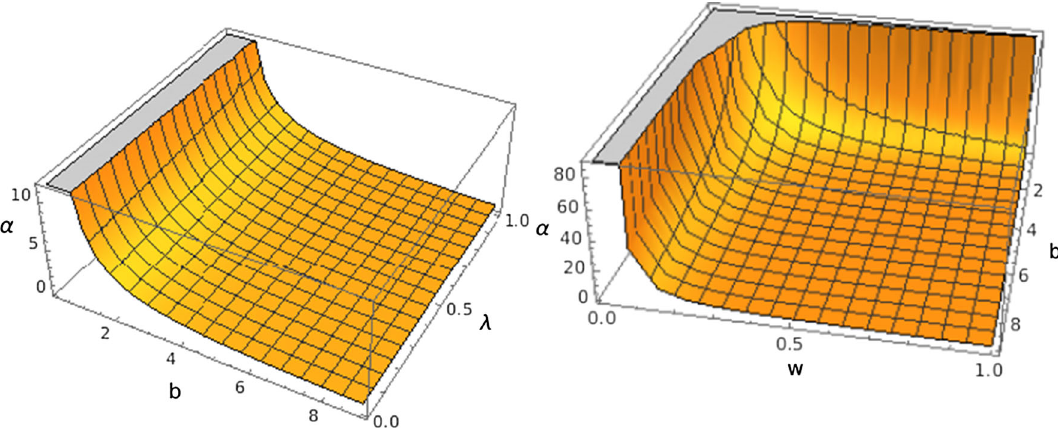
Fig. 2 The deflection angle has been plotted as a function of b and λ when w = 0 . 8, M = a = 1 in the left panel, whereas for a function of b and w when λ = 0 . 1, M = a = 1 in the right